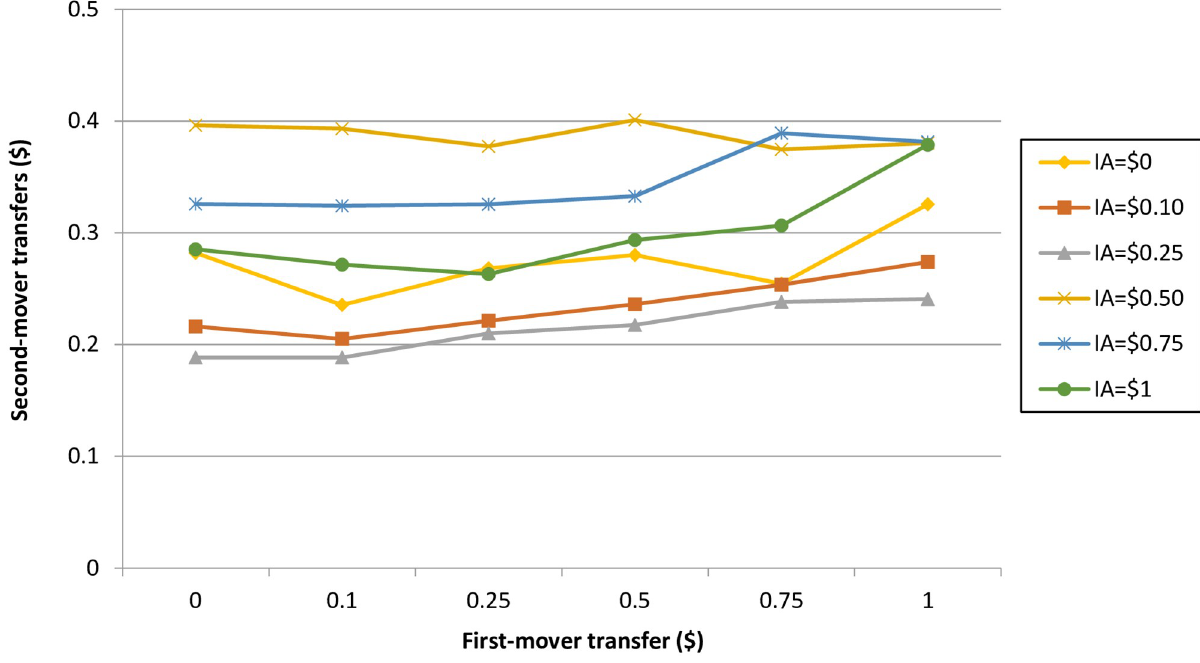
Fig 3. SM responses to FM transfers disaggregated by initial